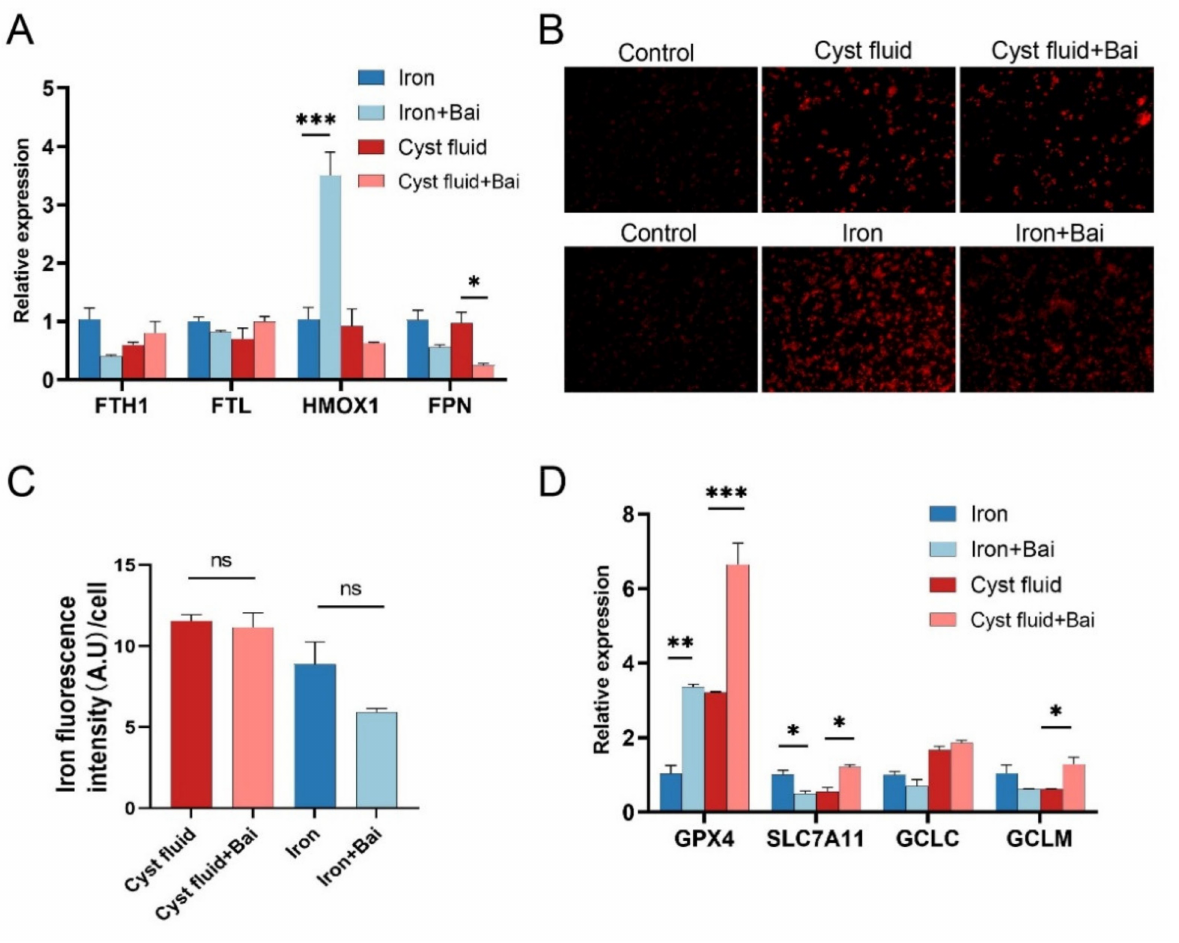
Figure 6. Baicalein promotes GPX4 expression but exerts no impact on iron transfer. ( A ) mRNA levels of iron metabolism-related genes expression in cyst fluid-treated (2%) and iron-treated THP- 1 cells in the absence or presence of 20 µ M baicalein for 12 h by RT-qPCR. ( B , C ) FerroOrange specific fluorescence in THP-1 cells after treatment of 2% cyst fluid and 200 µ g/mL FeSO 4 in the absence or presence of 20 µ M baicalein for 12 h. The scale bars = 100 µ m. ( D ) mRNA levels of ferroptosis suppressor gene metabolism expression in cyst fluid-treated and iron-treated THP-1 cells for 12 h determined by RT-qPCR.GPX4: glutathione peroxidase 4; SLC7A11: solute carrier family 7 member 11; GCLC: glutamate-cysteine ligase catalytic subunit; GCLM: glutamate-cysteine ligase modifier subunit; A.U: arbitrary unit. * p < 0.05, ** p < 0.01, *** p <